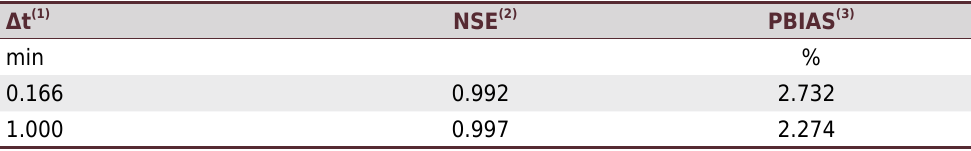
Table 1. Performance of the device calibration curve (n=4)